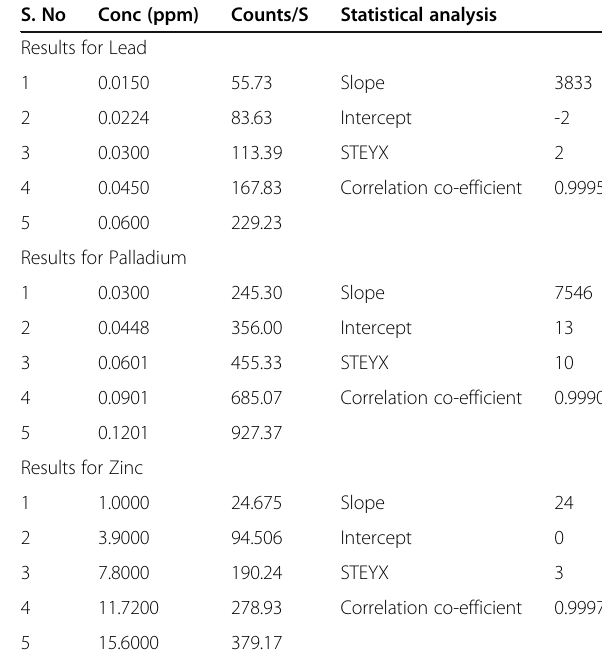
Table 7 Linearity experiment results